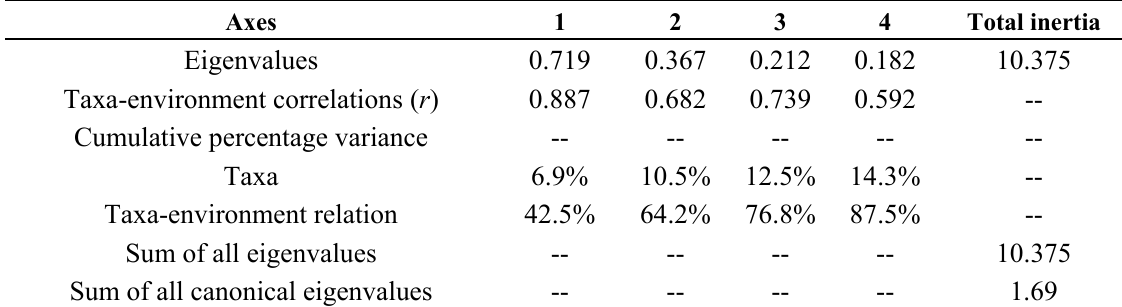
Table 1. The result of canonical correlation analysis between environmental factors and benthic macro-invertebrate taxa of each sampling sites of the Tanshui River system in 2012.